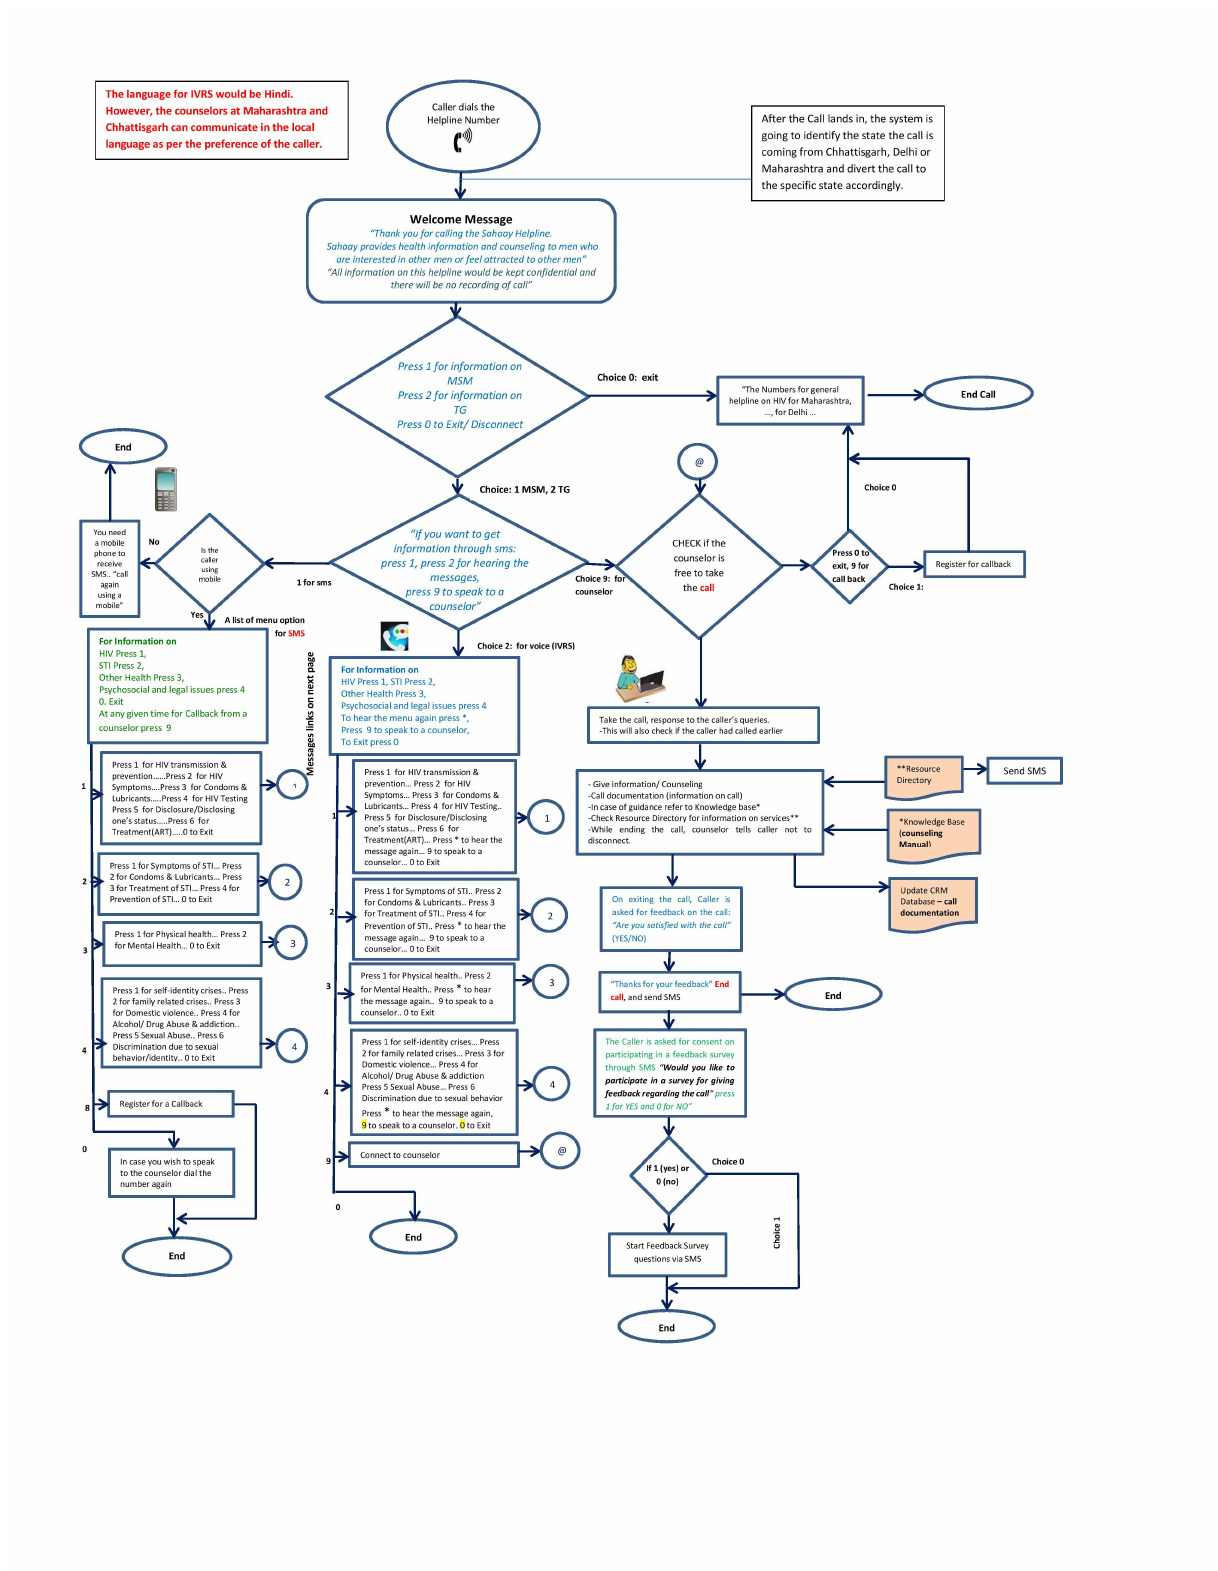
Figure 2. Helpline interactive voice response system